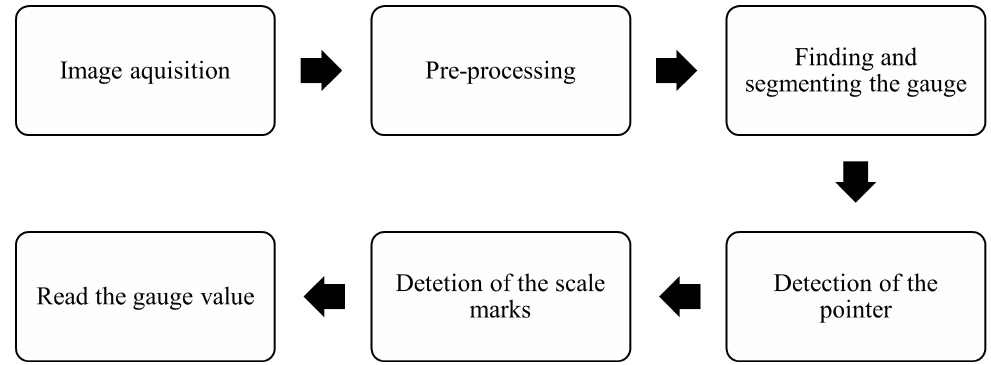
Figure 1. Flowchart of conventional approaches to automatic gauge